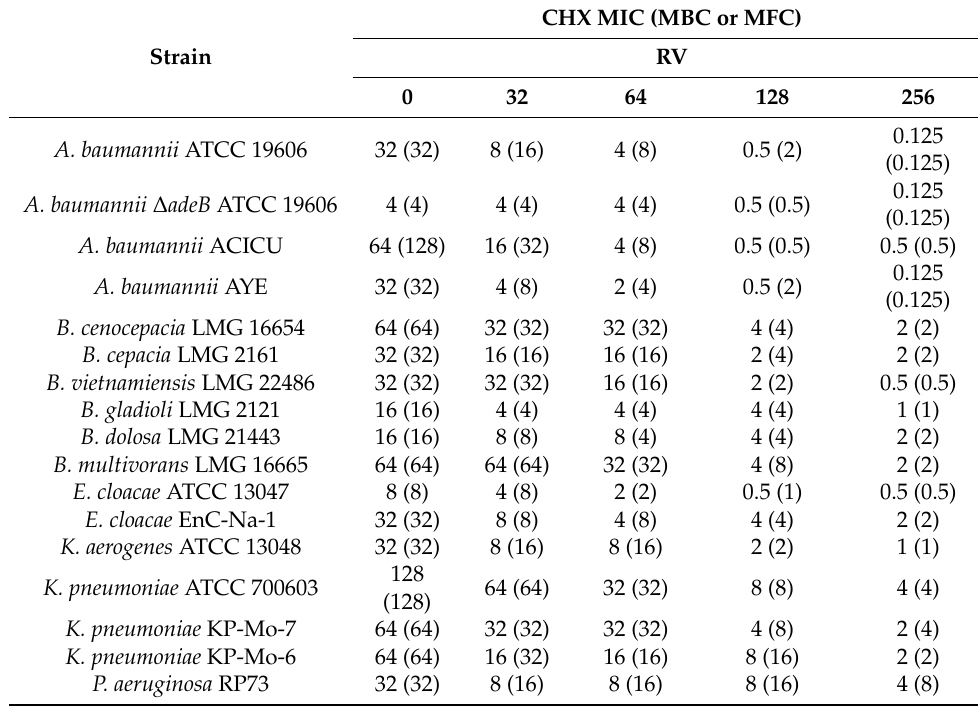
Table 2. Effect of RV (mg/L) on CHX MIC (mg/L) and MBC (MFC in the case of Candida spp.) (mg/L) against Gram-negative bacteria, Gram-positive bacteria and